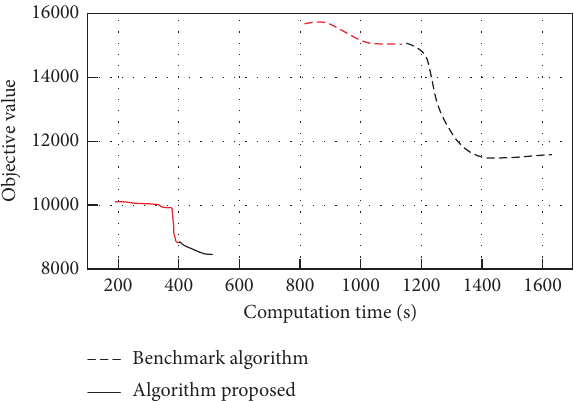
Figure 9: Solutions of the proposed and benchmark algorithms with computation times.